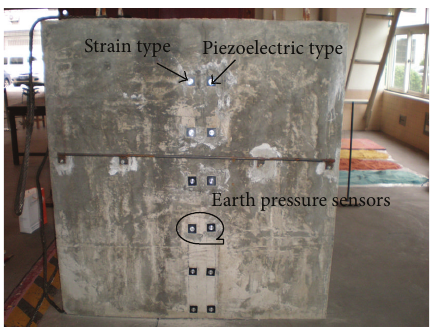
Figure 2: Gravity retaining wall model and earth pressure sensor installation